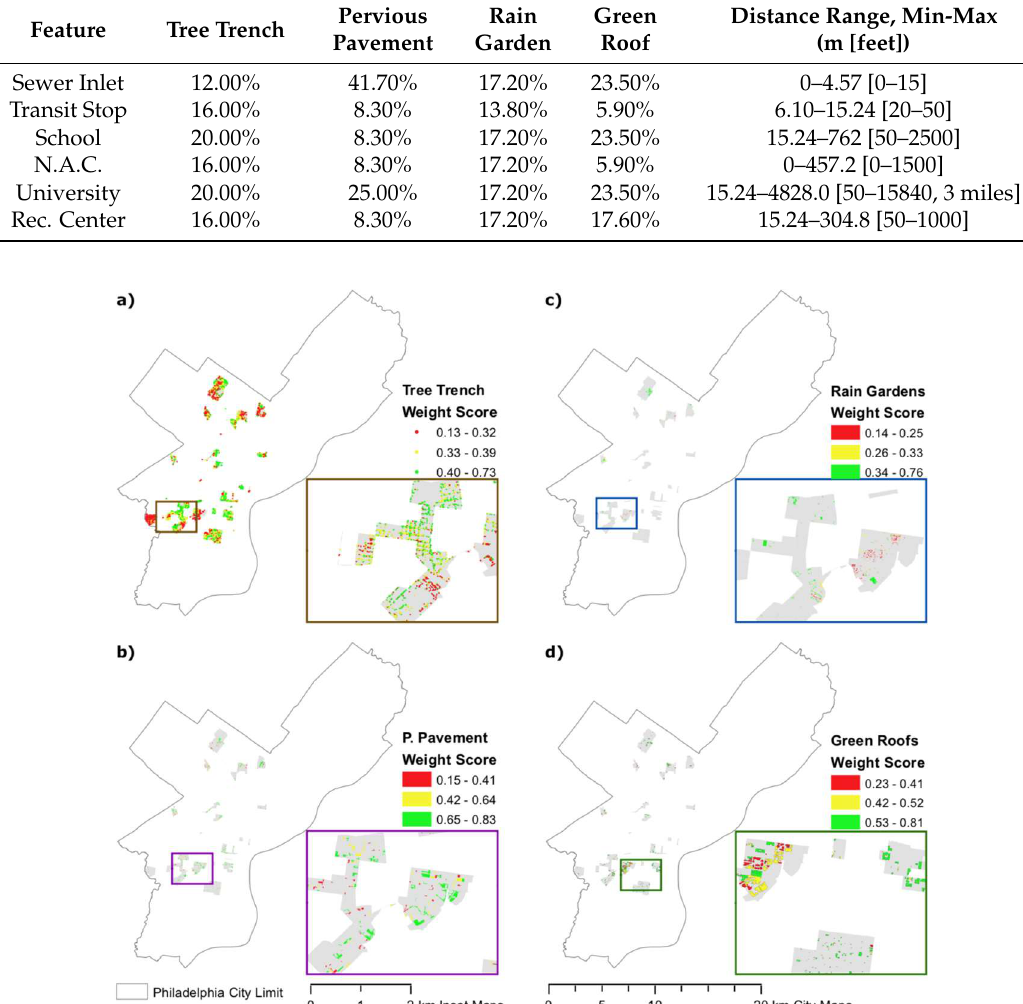
Figure 2. Ranked prioritization of potential GSI implementation sites by type of feature, across the City of Philadelphia.